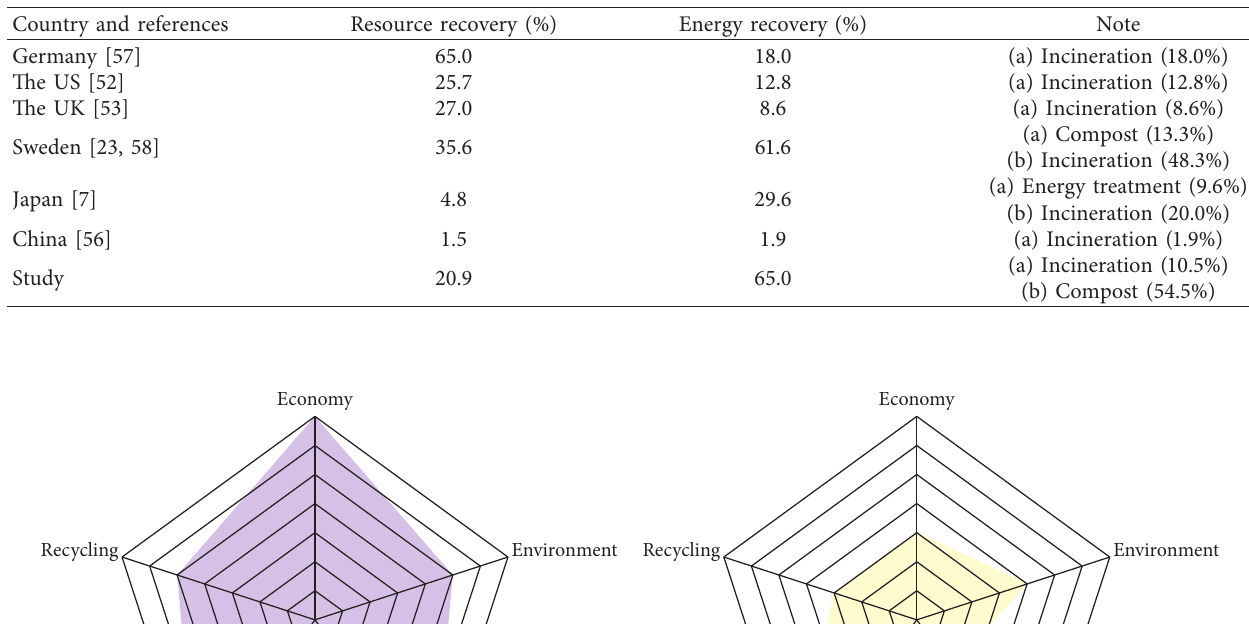
Table 8: Recycling energy and resource recovery rates.